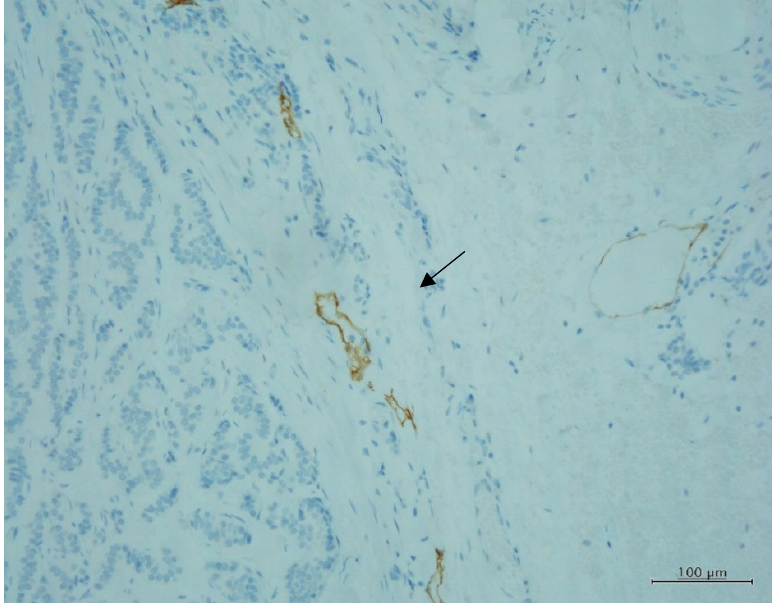
Figure 1. Rectal G1 NET 6 mm. D2-40 immunohistochemical stain showing lymphatic invasion (arrow) in the lymphatic vessels that had been cut diagonally. (×100).